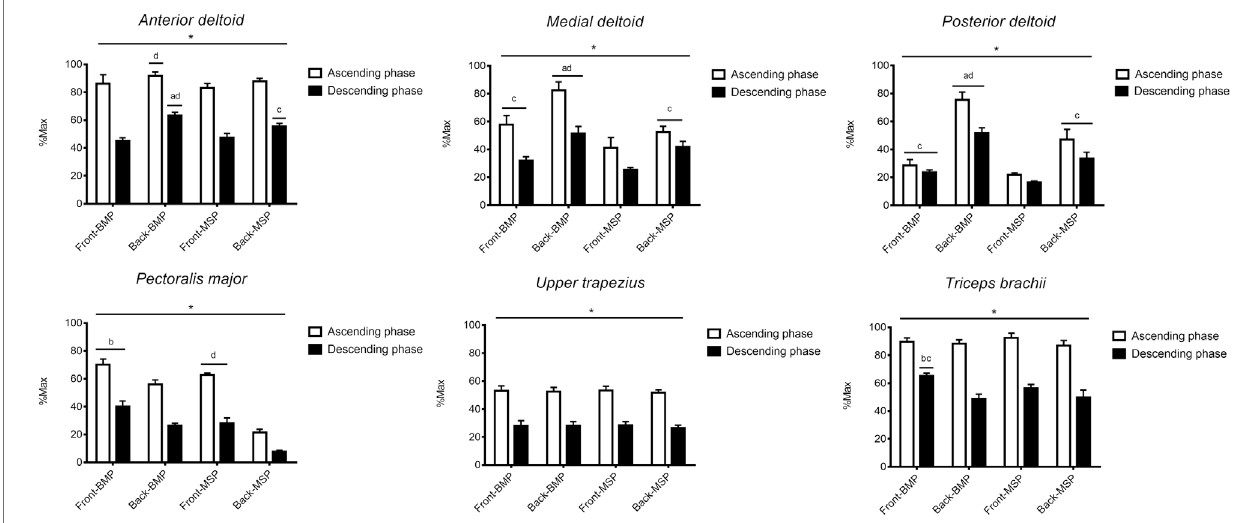
FIGURE 3 | Mean (SD) for the sEMG RMS of the muscles examined during the ascending and descending phase of each exercise. Besides the front vs. back and barbell vs. machine differences, sEMG RMS was greater during the ascending than descending phase in all exercises. a: p < 0.05 vs. front-BMP. b: p < 0.05 vs. back- BMP. c: p < 0.05 vs. front-MSP. d: p < 0.05 vs.